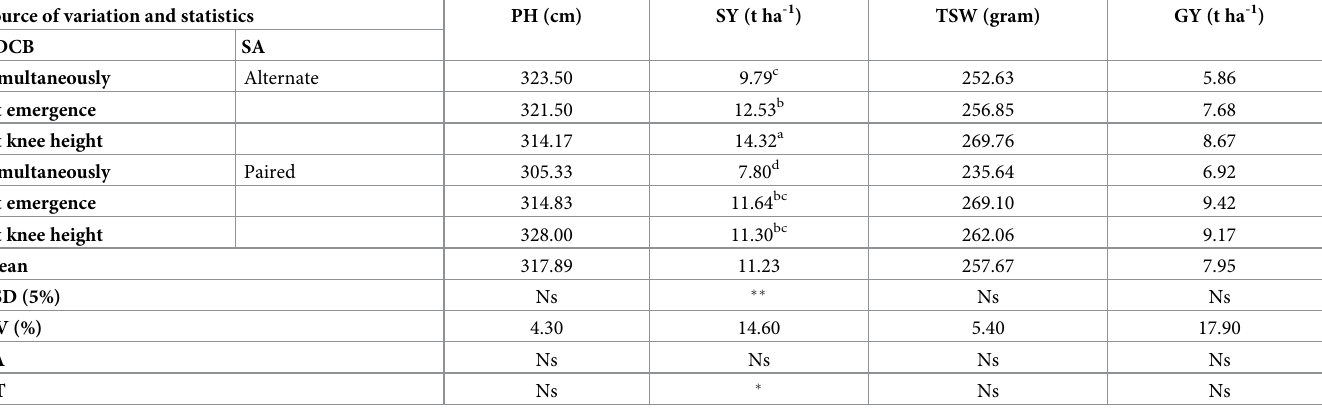
Table 2. Response of maize yield attribute and yield to spatial arrangement and planting time of common bean at Finoteselam sub-research station, Northwestern Ethiopia a . Source of variation and